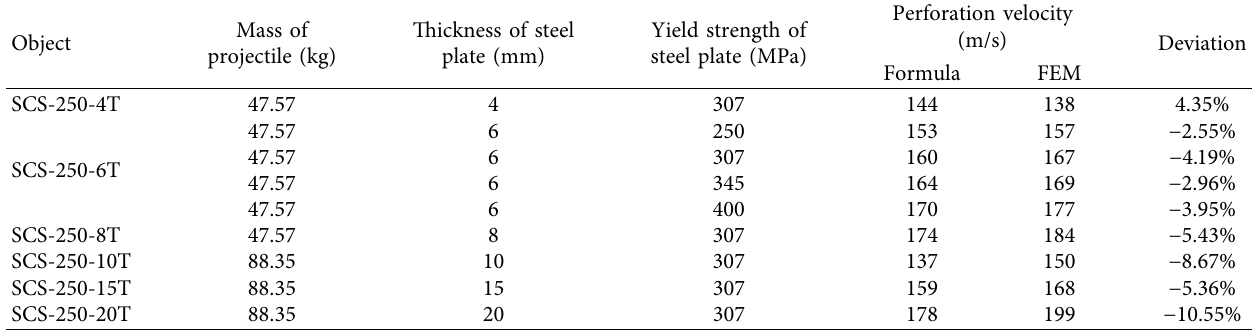
Table 9: Perforation velocity comparison of SCS wall with different conditions of steel plate for flat projectile. Object